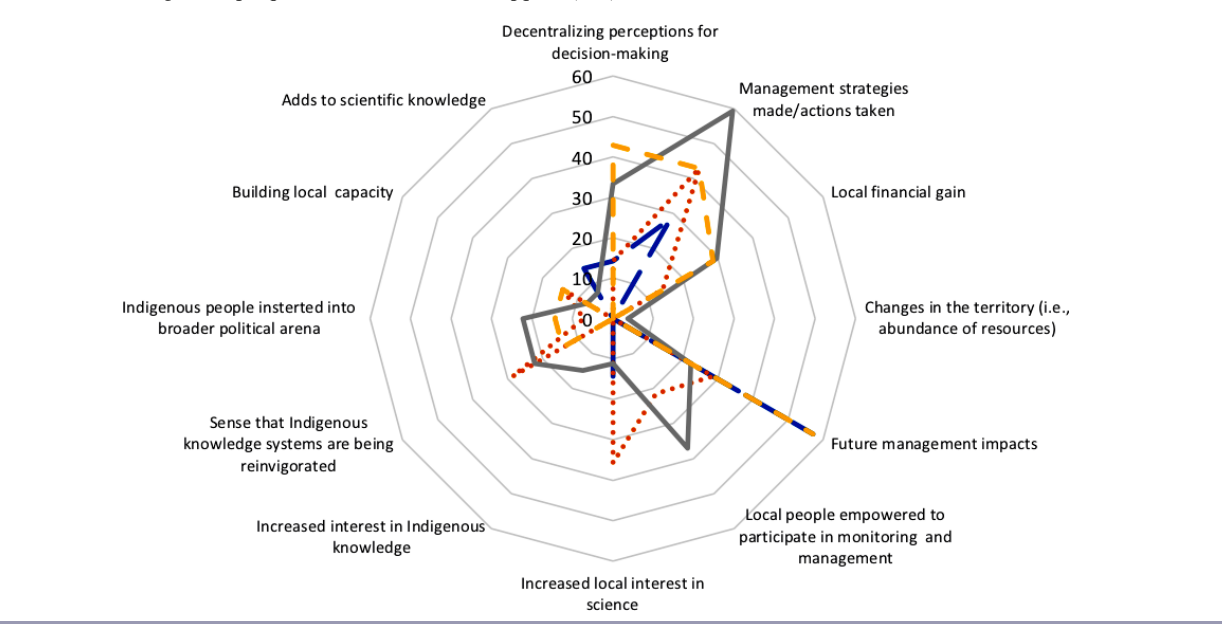
Fig. 7 . Percentage of monitoring initiatives at each level of Indigenous participation displayed according to monitoring outcomes. Initiatives are classified according to the degree of participation of Indigenous people: the blue dashed line indicates externally driven initiatives with Indigenous people as data collectors (IP1); the orange dotted line indicates collaborative initiatives with Indigenous people playing some role in design and execution (IP2); the grey solid line indicates collaborative initiatives with Indigenous people playing a strong role in design, execution, and management (IP3); and the yellow dashed line indicates autonomous monitoring by Indigenous people with some external support